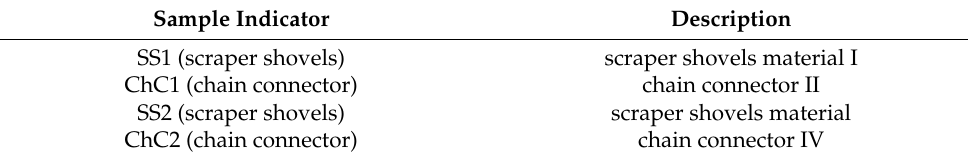
Figure 2. Views of the scraper shovel, linkage and connecting bolts of the RM 80 UHR bed ballast cleaning machine: ( a ) side view, ( b ) top view. Table 1. Sample